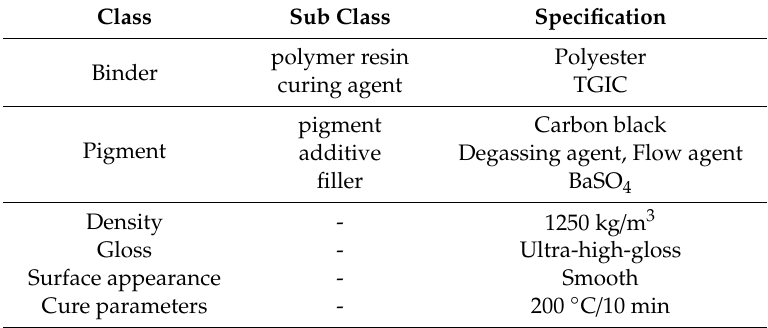
Table 1. Technical specifications of polyester powder paint used in the study.